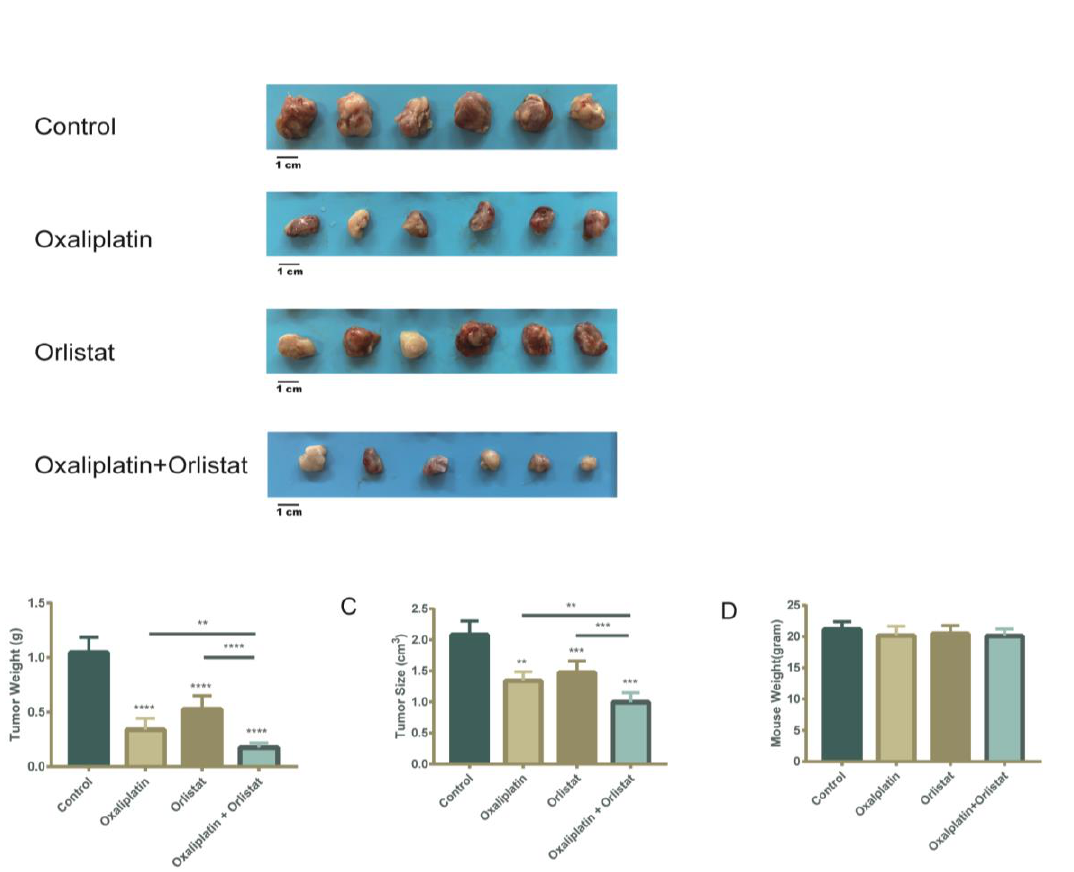
Table S2. ( E , F ) Under 20 µ M oxaliplatin treatment, phosphorylation levels in 116-LOHP and HCT8- LOHP cell lines decreased with increasing concentration gradients of Orlistat. Relative intensity ratio of each band on western blot see Table S3. The uncropped blots are shown in Figure S5. * p ≤ 0.05, **